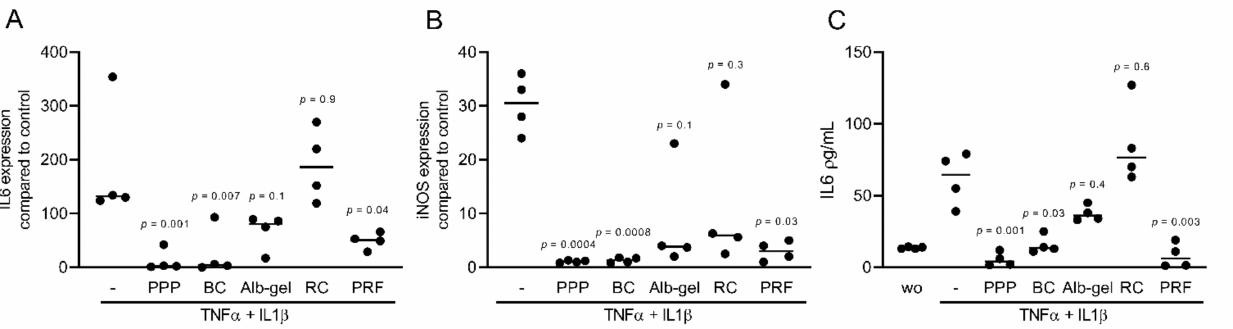
Figure 2. PPP, BC, and PRF lysates reduced cytokine-induced inflammation in murine 3T3-L1 cells. 3T3-L1 cells were treated with 10% of PPP, BC, Alb-gel, RC, and 30% of PRF in the presence of the inflammatory cytokines TNF α and IL1 β . ( A , B ) Data indicate the x-fold changes of IL6 and iNOS expression ( C ) and the IL6 levels in the cell supernatant, n = 4.